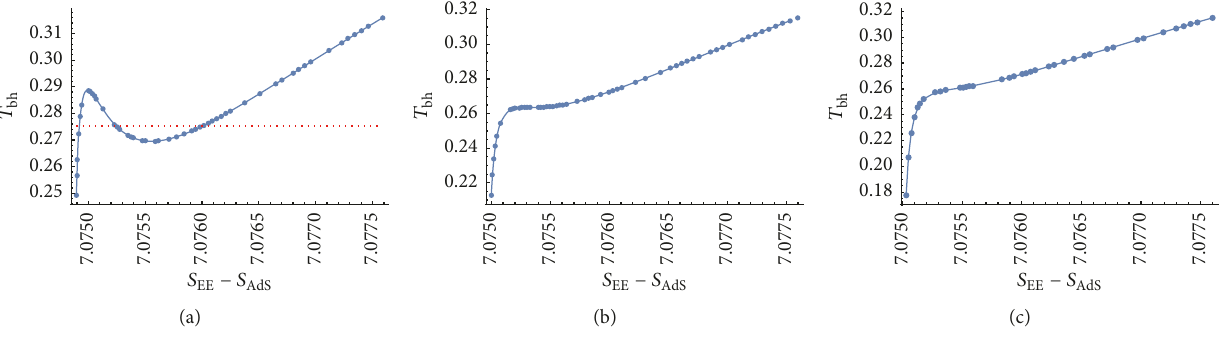
relation between log |𝑇 − 𝑇 𝑐 | and log |𝛿𝑆 − 𝛿𝑆 𝑐 | is plotted in Figure 11. The analytical results of these straight lines can also be fitted, which are for 𝜑 0 = 0.10